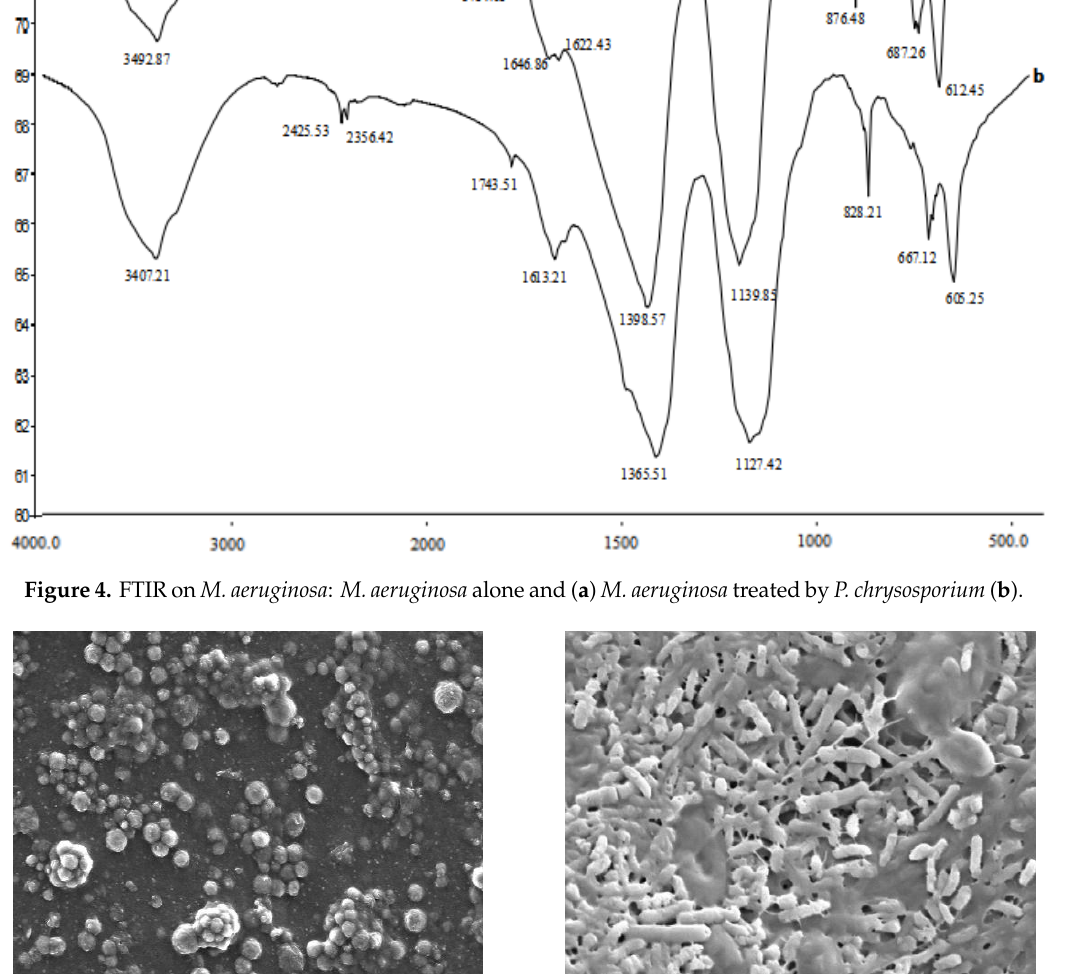
Figure 5. SEM on M. aeruginosa : M. aeruginosa alone and ( a ) M. aeruginosa treated by P. chrysosporium ( b ).